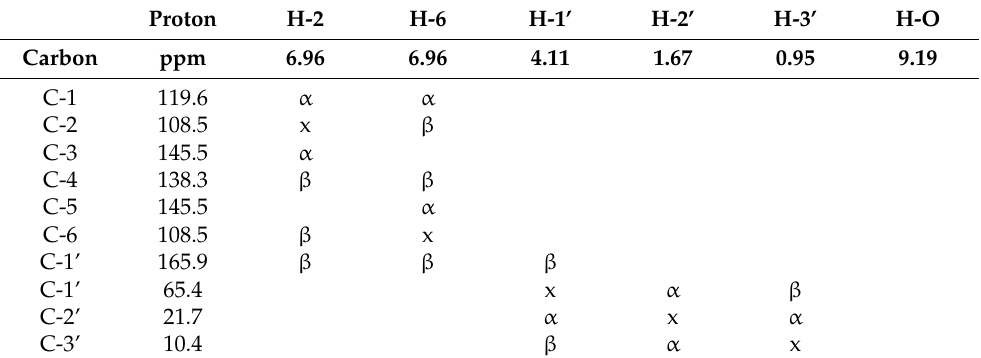
Table 7. Two-dimensional (2D) NMR (HSQC and HMBC) correlations for the title compound III .